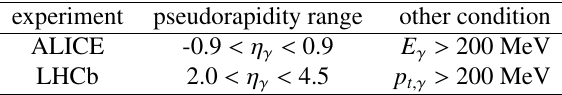
Table 1. Fiducial region used in the